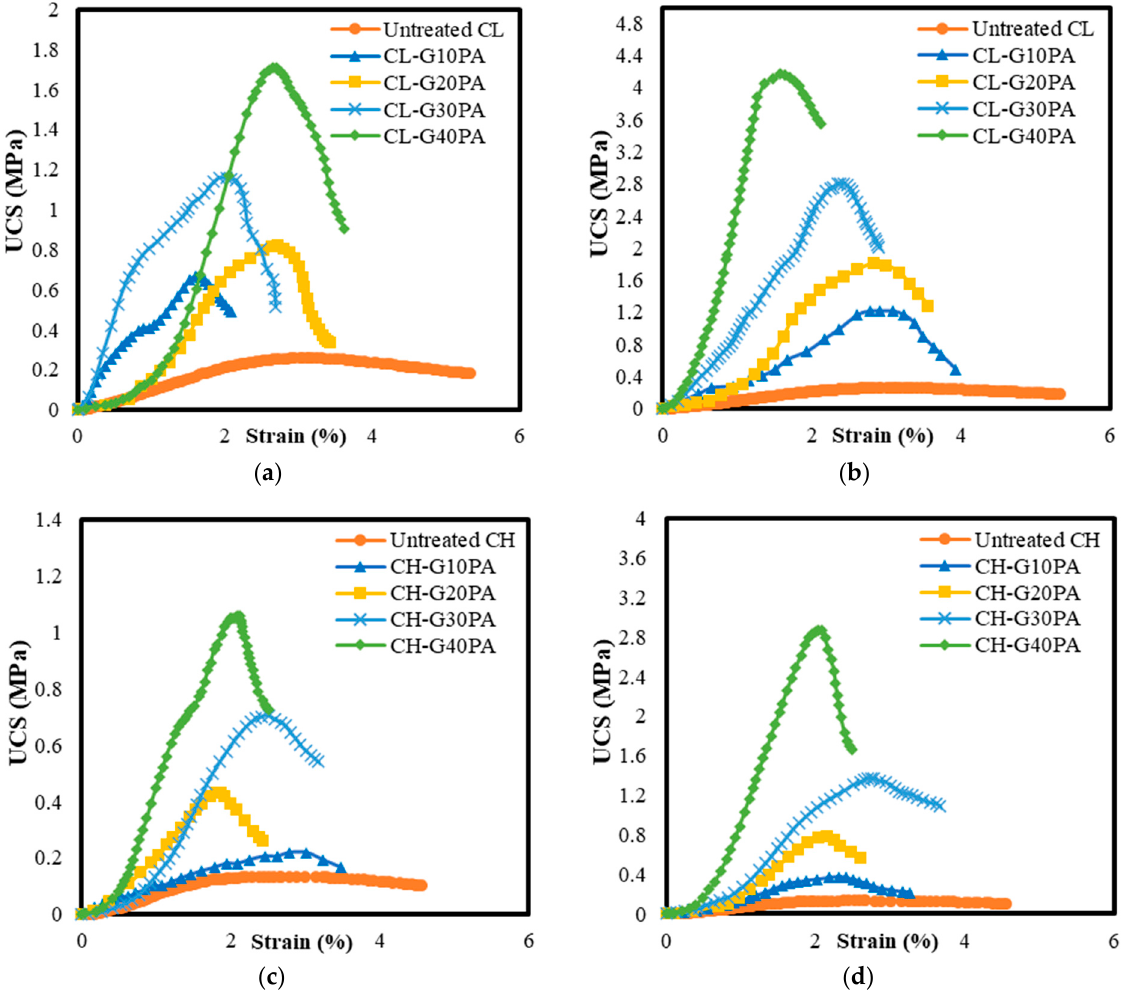
Figure 4. Stress-strain curves of POFA-based geopolymer-treated soils: ( a ) 7 days CL, ( b ) 28 days CL, ( c ) 7 days CH, ( d ) 28 days CH.